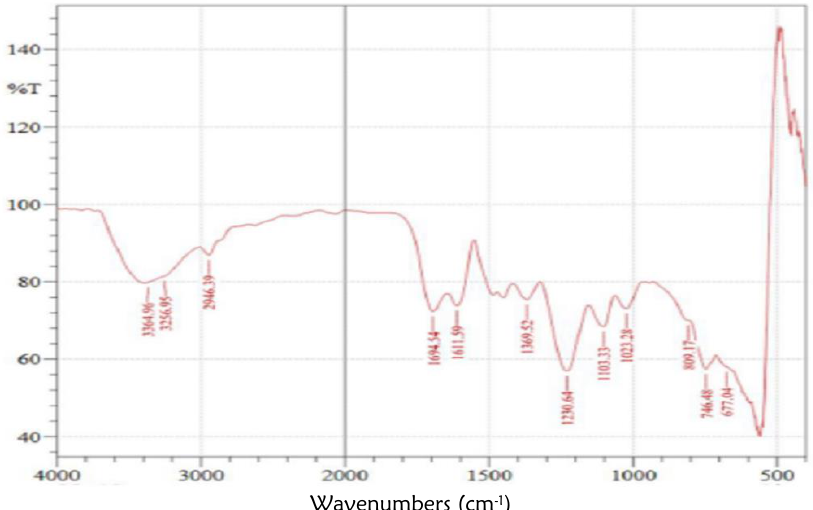
Figure 9: Functional group of Bio-oil for 35g sample at 15